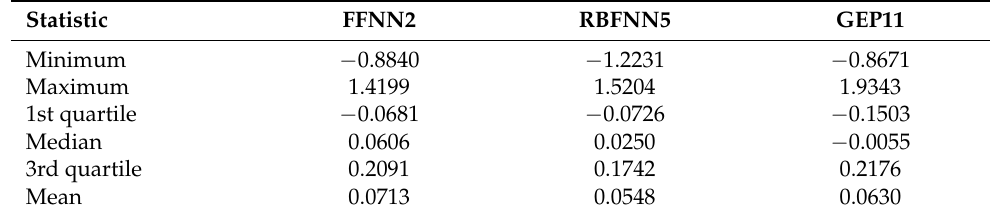
Table 10. Statistical criteria for the best combination of